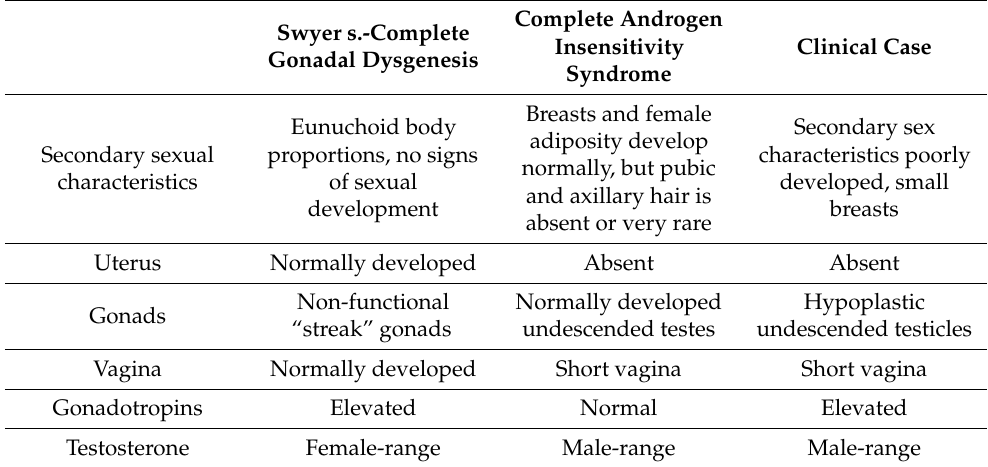
Table 1. Main characteristics of complete gonadal dysgenesis and complete androgen insensitivity syndrome compared to our case report patient’s clinical findings. Complete Androgen Swyer s.-Complete Insensitivity Clinical Case Gonadal Dysgenesis Syndrome Breasts and female Secondary sex Eunuchoid body characteristics poorly proportions, no signs Secondary sexual developed, small of sexual characteristics breasts development Uterus Absent Absent Non-functional Hypoplastic Gonads “streak” gonads undescended testes undescended testicles Vagina Normally developed Short vagina Short vagina Gonadotropins Elevated Normal Elevated Testosterone Female-range Male-range